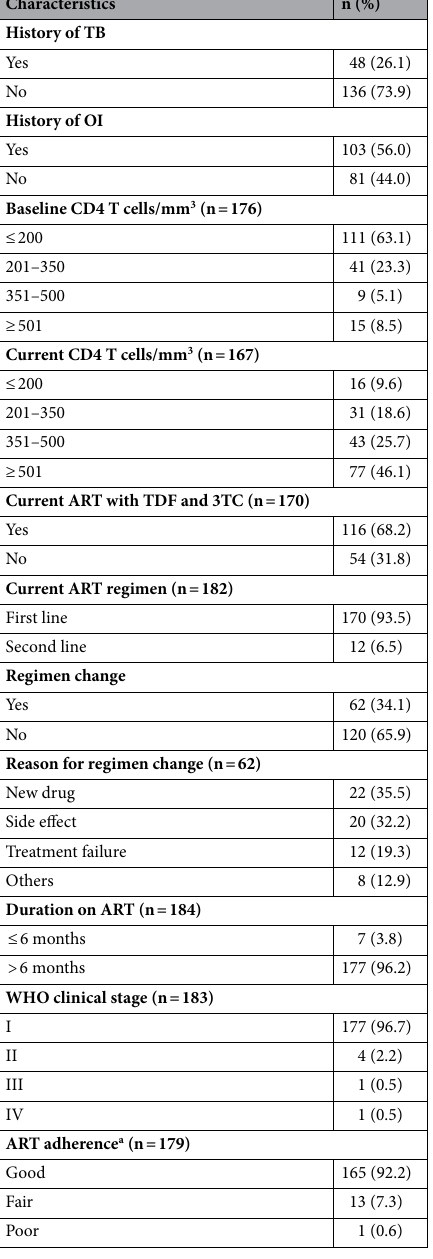
Table 3. Clinical characteristics of HIV positive IAHBc individuals on ART in three public hospitals, eastern Ethiopia 2017/18. Fair = 85–94% adherence, missed 3–5 doses (of 30 doses), missed 3–9 doses (of 60 doses). Poor = < 85% adherence, missed ≥ 6 doses (of 30 doses), missed > 9 doses (of 60 doses). a Good = > 95% adherence, missed ≤ 2 doses (of 30 doses), missed ≤ 3 doses (of 60